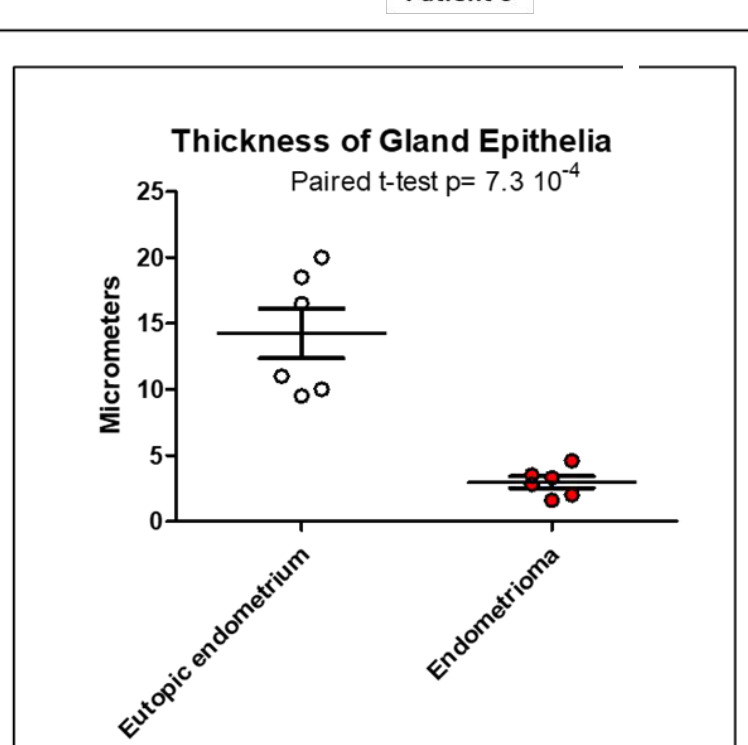
Figure 4. Immunohistochemistry staining of KIAA1324 in ovarian endometrioma and eutopic endometrium (A) and quantification by ImageJ (B). n = 6 patients with endometriosis. OMA: endometrioma; EE: eutopic endometrium. We used a designed antibody against the COOH-terminal peptide of KIAA1324 (1:100).